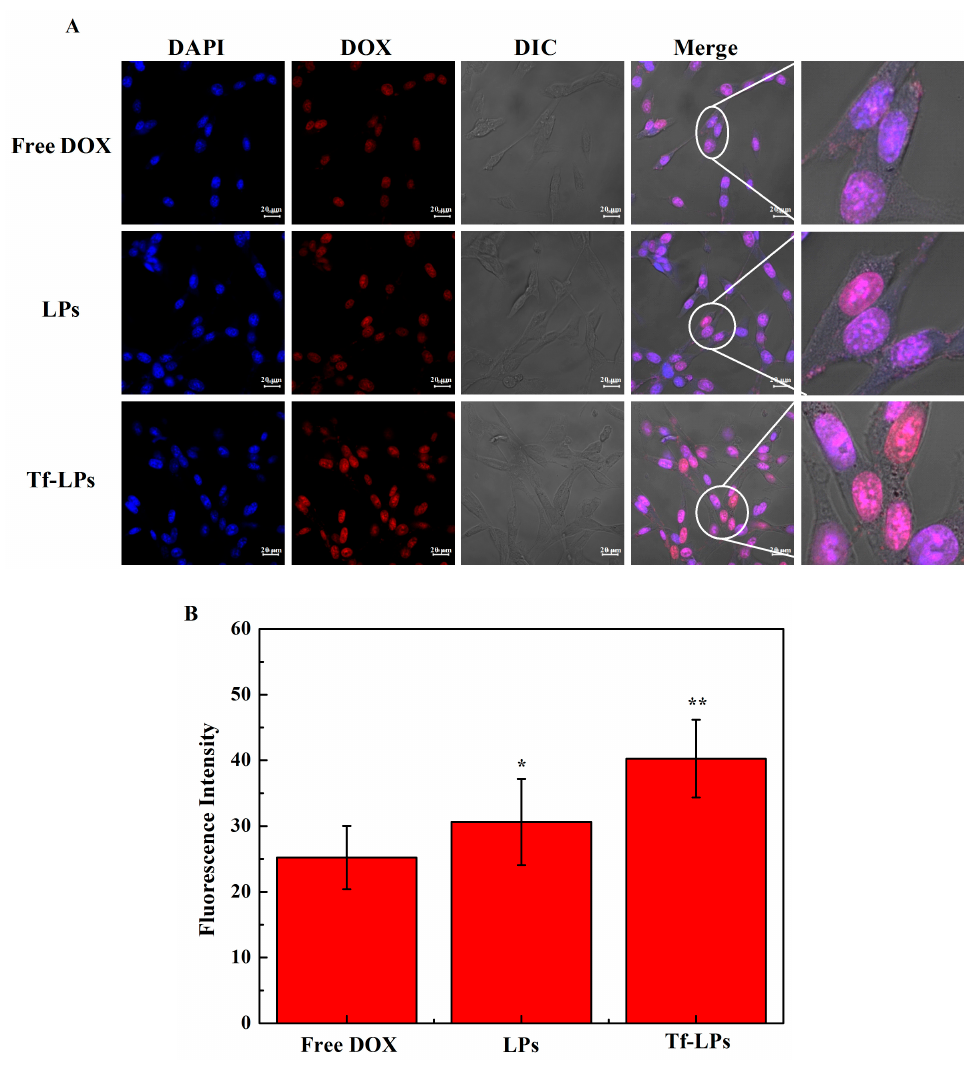
Figure 3. Cellular uptake of Tf-LPs ( n = 3). ( A ) Confocal laser scanning microscopy (CLSM) images of U87 cells after incubation with free DOX, LPs and Tf-LPs for 4 h, ( B ) the fluorescence intensity of DOX channels when U87 cells were treated with free DOX, LPs and Tf-LPs for 4 h. U87 cells showed the best cellular uptake for Tf-LPs. Abbreviations: LPs, DOX-loaded liposomes; Tf-LPs, DOX-loaded Tf-liposomes.